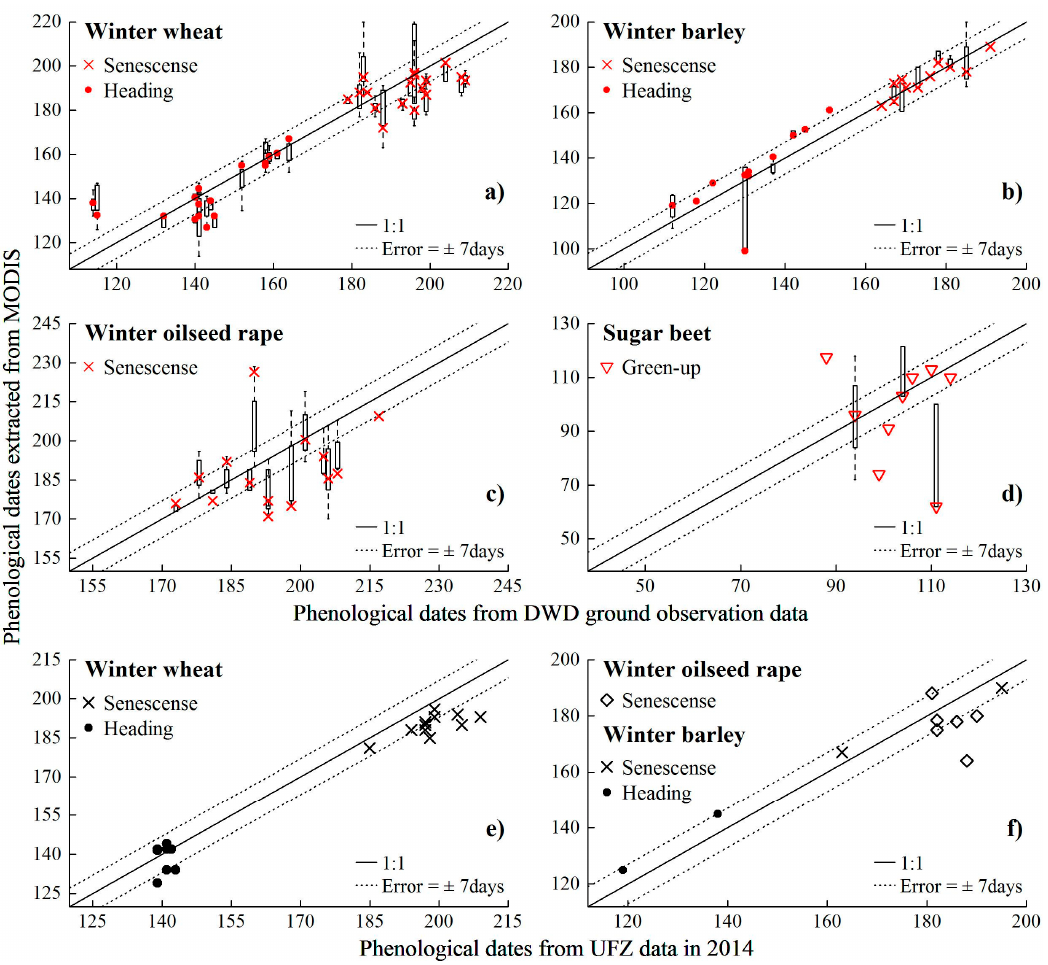
Figure 5. Calibration results of satellite-derived phenological dates for different crops in: ( a – d ) 2010, 2011, 2012 and 2014 versus DWD data; ( e , f ) 2014 versus UFZ data. Red-coloured symbols indicate fields which were closest to DWD stations. Each box represents phenostages of all fields which were within 3 km around one DWD station.